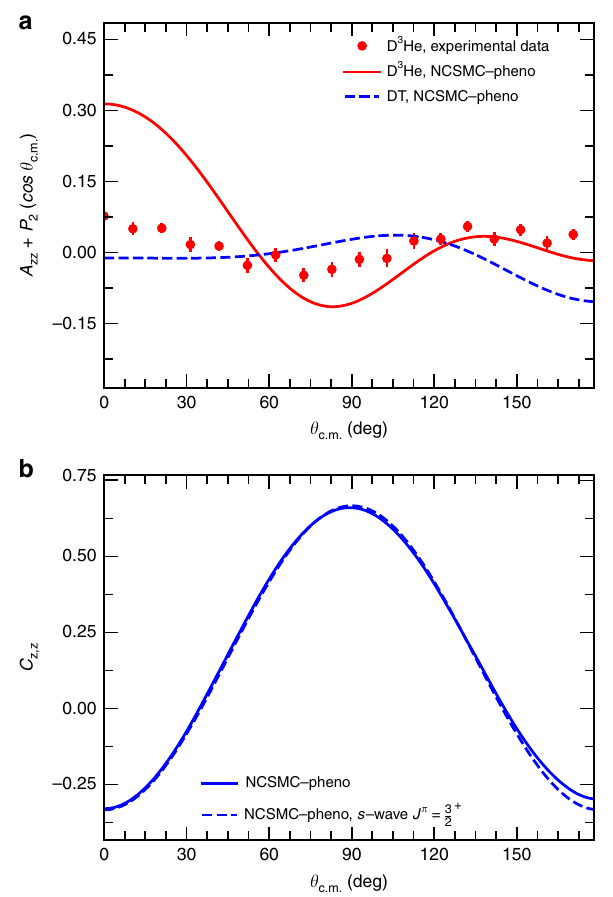
Fig. 3 DT and D 3 He polarization observables. a Computed and measured 32 (cid:7) (cid:8) of the D 3 He fusion reaction as a function of tensor analyzing power A ð b Þ zz the scattering angle in the center-of-mass (c.m.) frame, θ c.m. at the deuterium incident energy of E D = 424 keV compared to the results for the DT fusion reaction at E D = 100 keV (the corresponding energy, once the difference in the Q -values of the two reactions is taken into